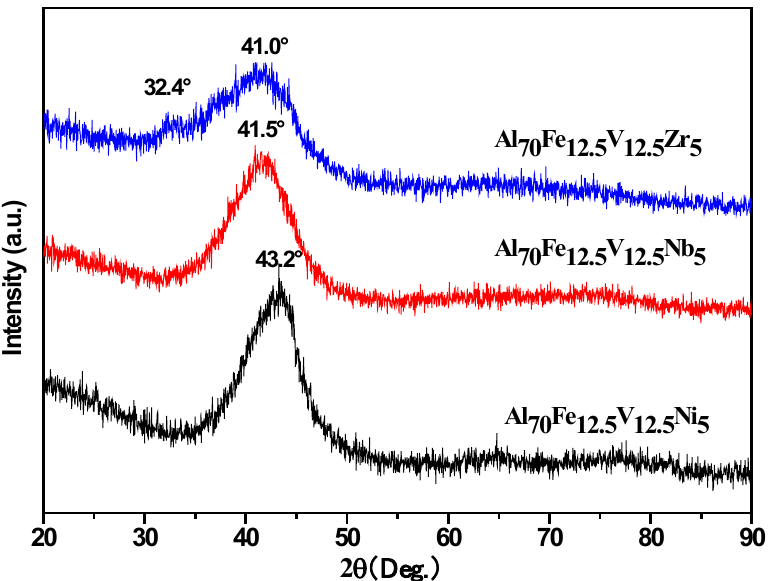
Figure 1. The X-ray diffraction (XRD) patterns of Al-Zr, Al-Nb and Al-Ni alloys milled for 100 h, 60 h and 50 h, respectively.